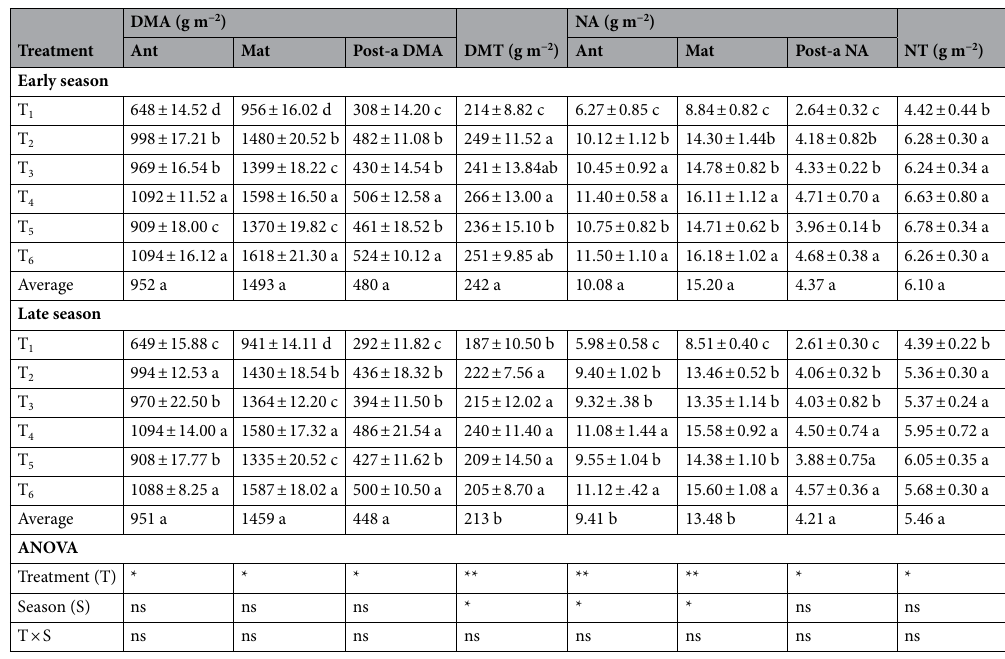
Table 2. Pre-and post-anthesis dry matter and nitrogen accumulation and translocation under the combined organic manure and inorganic fertilization. DMA dry matter accumulation, DMT dry matter translocation, NA nitrogen accumulation, NT nitrogen translocation, Ant anthesis, Mat maturity, Post-a anthesis accumulation. Values followed by the same letters, within column, are statistically non-significant at ( p < 0.05). Mean values (n = 3) ± SE. ns: non significant, * p < 0.05, ** p < 0.05. For treatment details please see Table 1.